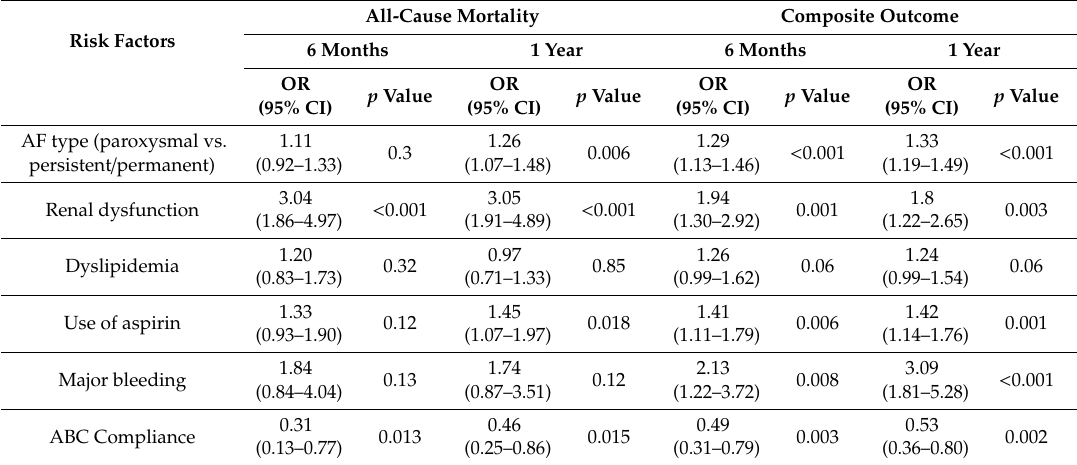
Table 3. Clinical outcomes at six-months and one-year